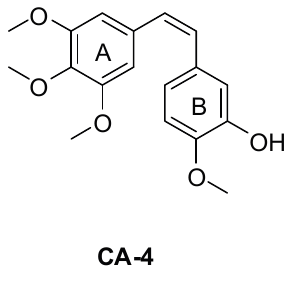
Figure 1. Structure of CA-4 .